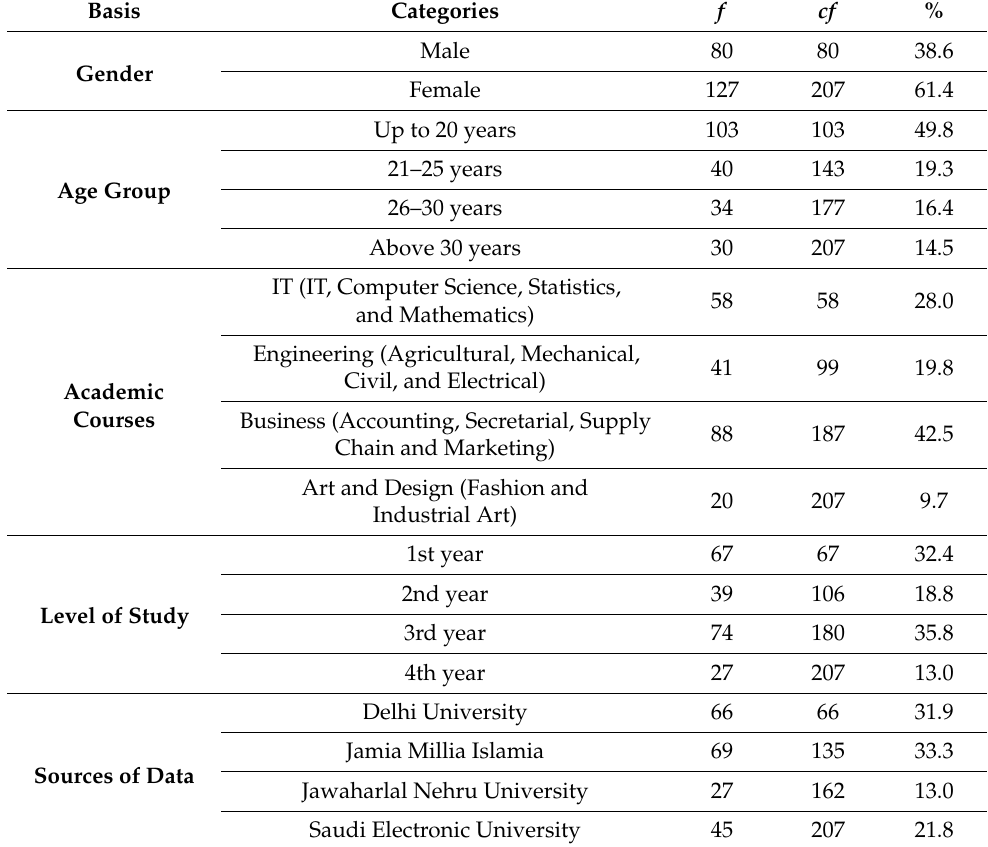
Table 1. Baseline Data of the Participants ( N =